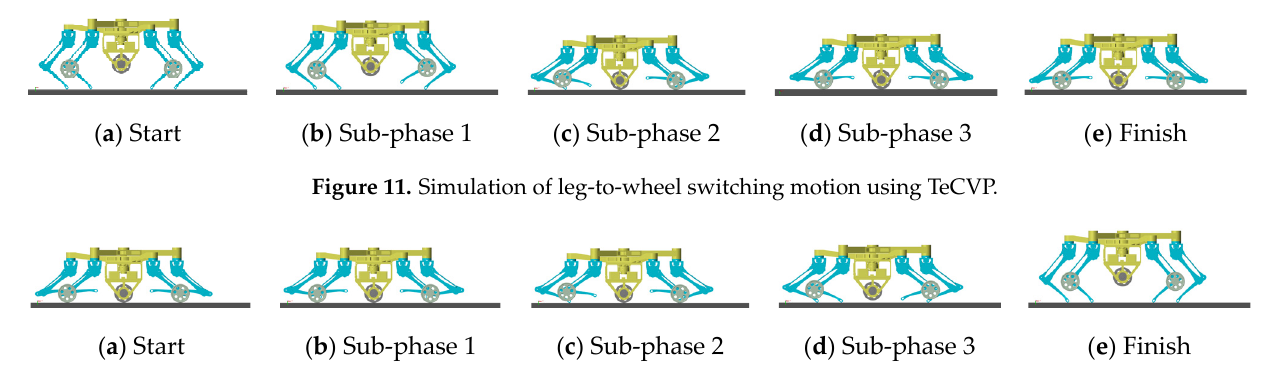
Figure 12. Simulation of wheel-to-leg switching motion using TeCVP.